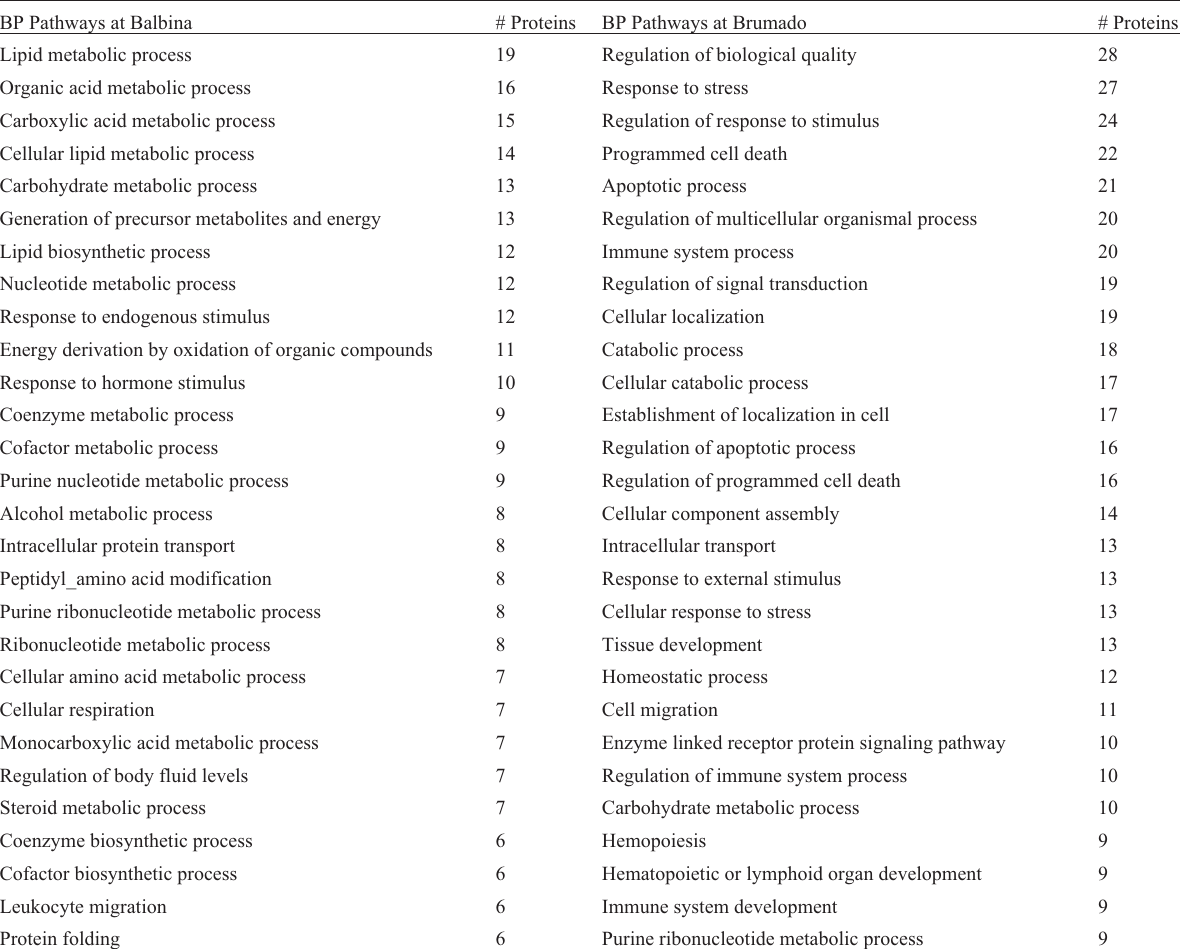
Table 3 - List of enriched biological processes represented in the protein-protein interactions (PPI) networks of both the Balbina and Brumado popula- tions. BP Pathways at Balbina # Proteins BP Pathways at Brumado # Proteins Lipid metabolic process